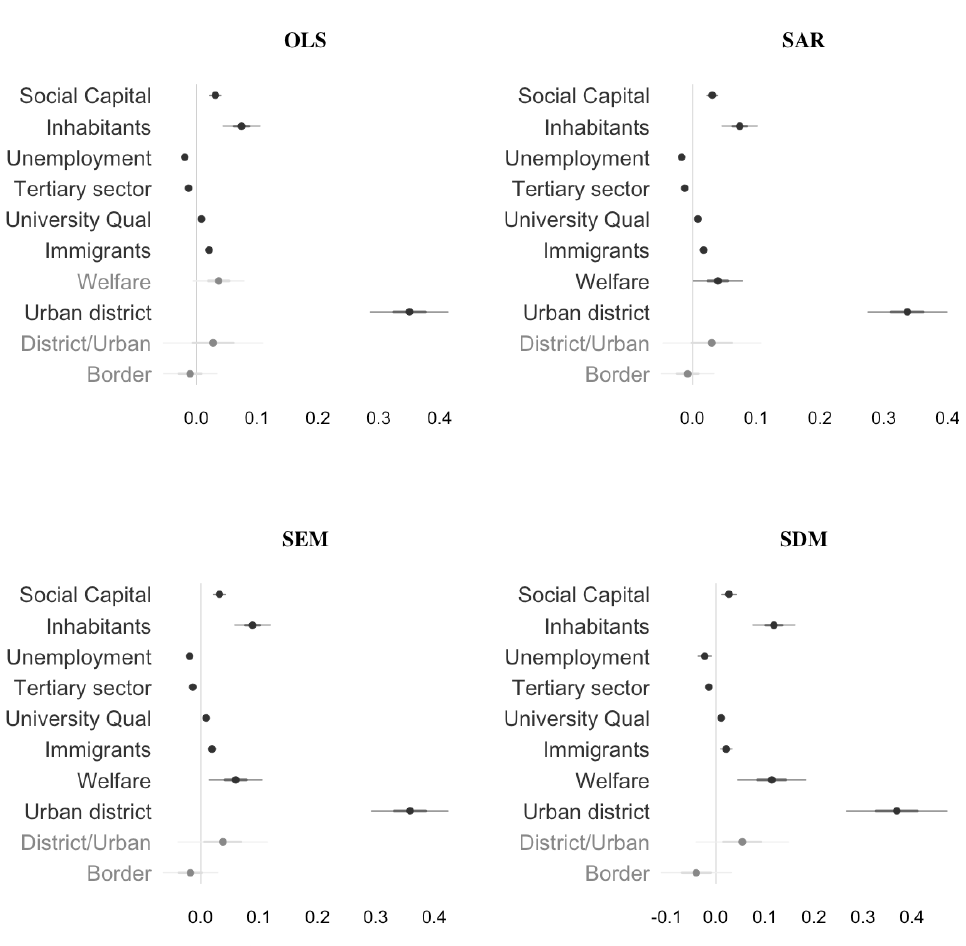
REGION : Volume 3, Number 1,